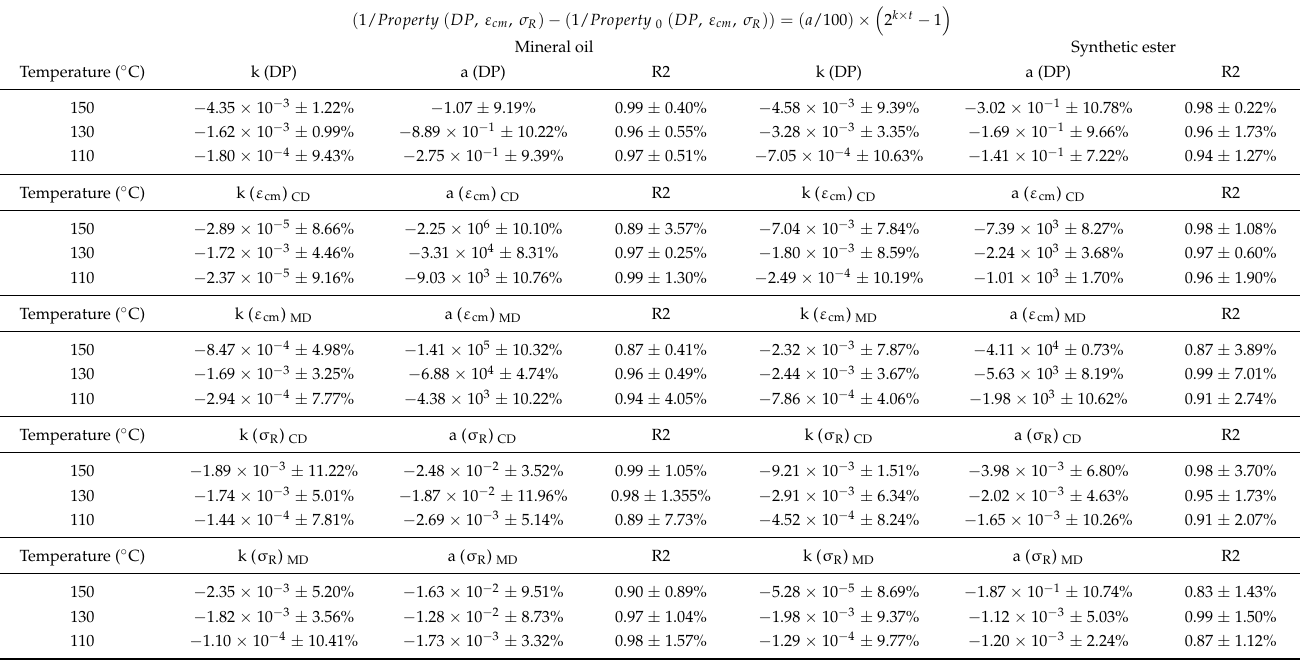
Table 6. Constant rates of reaction for the Zervos model based on DP, ε cm, and σ R for different insulation